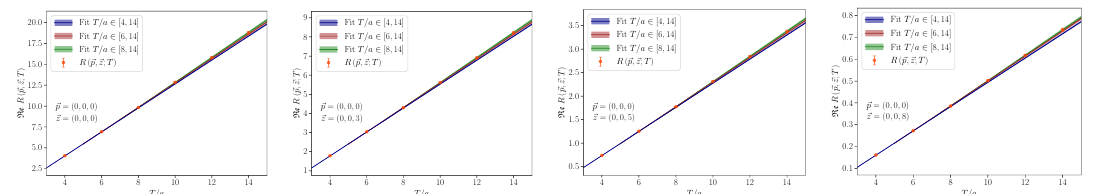
Figure 1 . Real component of the summed ratio R ( ~p,~z ; T ) for ~p = ~ 0 together with the linear fit eq. 3.7 applied for varying temporal series. The length of the Wilson line is increased from left to right, and given in integer multiples of the lattice spacing. Each panel corresponds to R ( ~p,~z ; T ) determined from a particular subduced correlation function, which are discussed in section